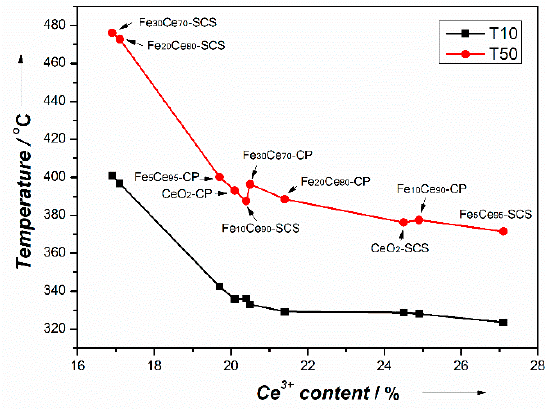
Figure 9. Relation between Ce 3 + percentage and T10, T50.